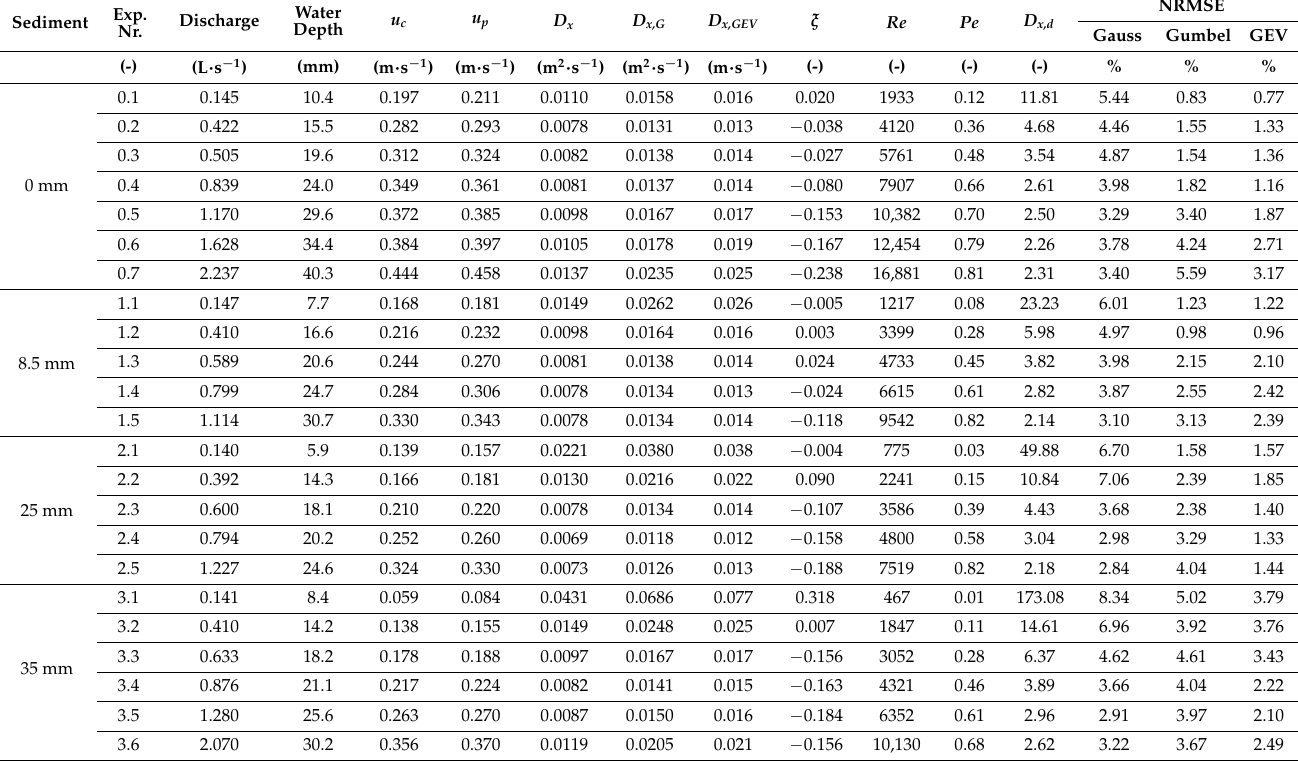
Table 1. Summary of the tracer experiments